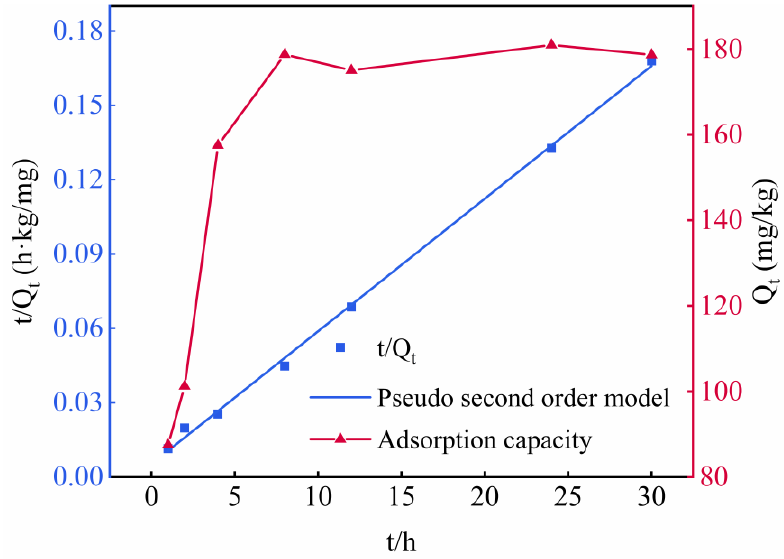
Figure 6. Pseudo-second-order kinetic model and adsorption rate curve of ITs.